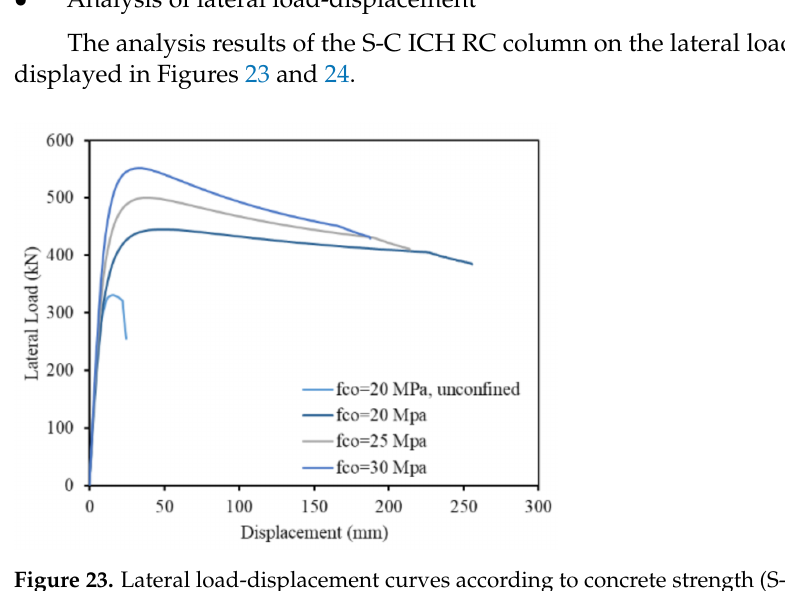
Figure 23. Lateral load-displacement curves according to concrete strength (S-C cross-section).